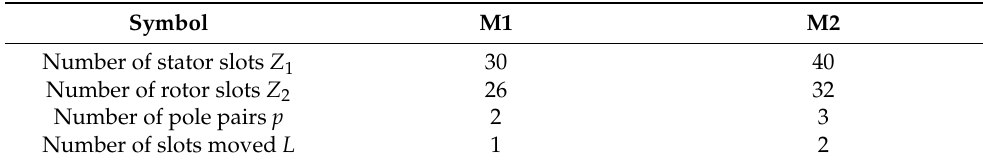
Table 1. Generic five-phase fractional slot motors M1 and M2. Symbol M1 M2 Number of stator slots Z 1